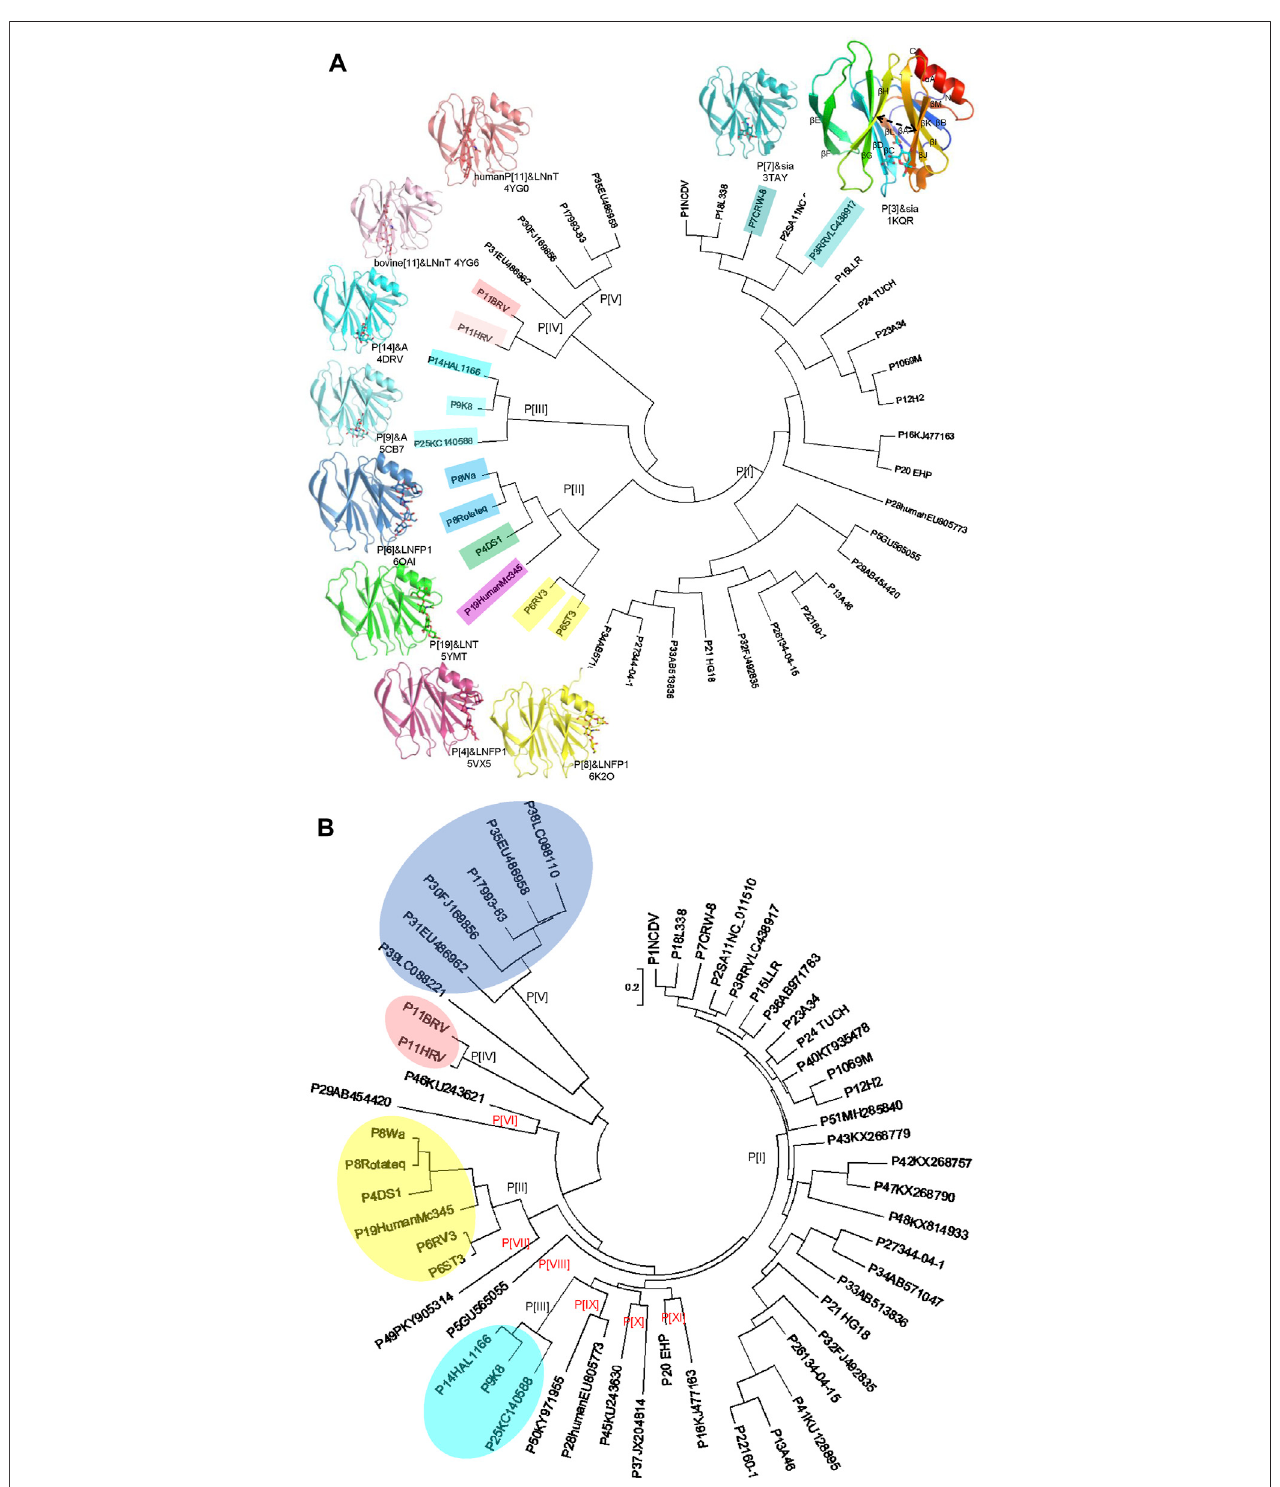
FIGURE2|(A) CrystalstructuresofrotavirusVP8*s. Phylogenetic analysisofVP8*sof35RVPgenotypes (circular dendrogram) wasconducted byMEGA6using the neighbor-joining method. The crystal structures of VP8*s in complex with glycans are presented. P[3], Rhesus rotavirus RRV in complex with Sia, rainbow, PDB ID: 1KQR.P[7],CRW-7incomplexwithsia,teal,PDBID:3TAY.P[14],humanrotavirusHAL1166incomplexwithA-typeHBGA,cyan,PDBID:4DRV.P[9],humanrotavirus K8 in complex with A-type HBGA, Aquamarine, PDB ID: 5CB7. P[11], human neonatal rotavirus N155 in complex with type II tetrasaccharide LNnT, salmon, PDB